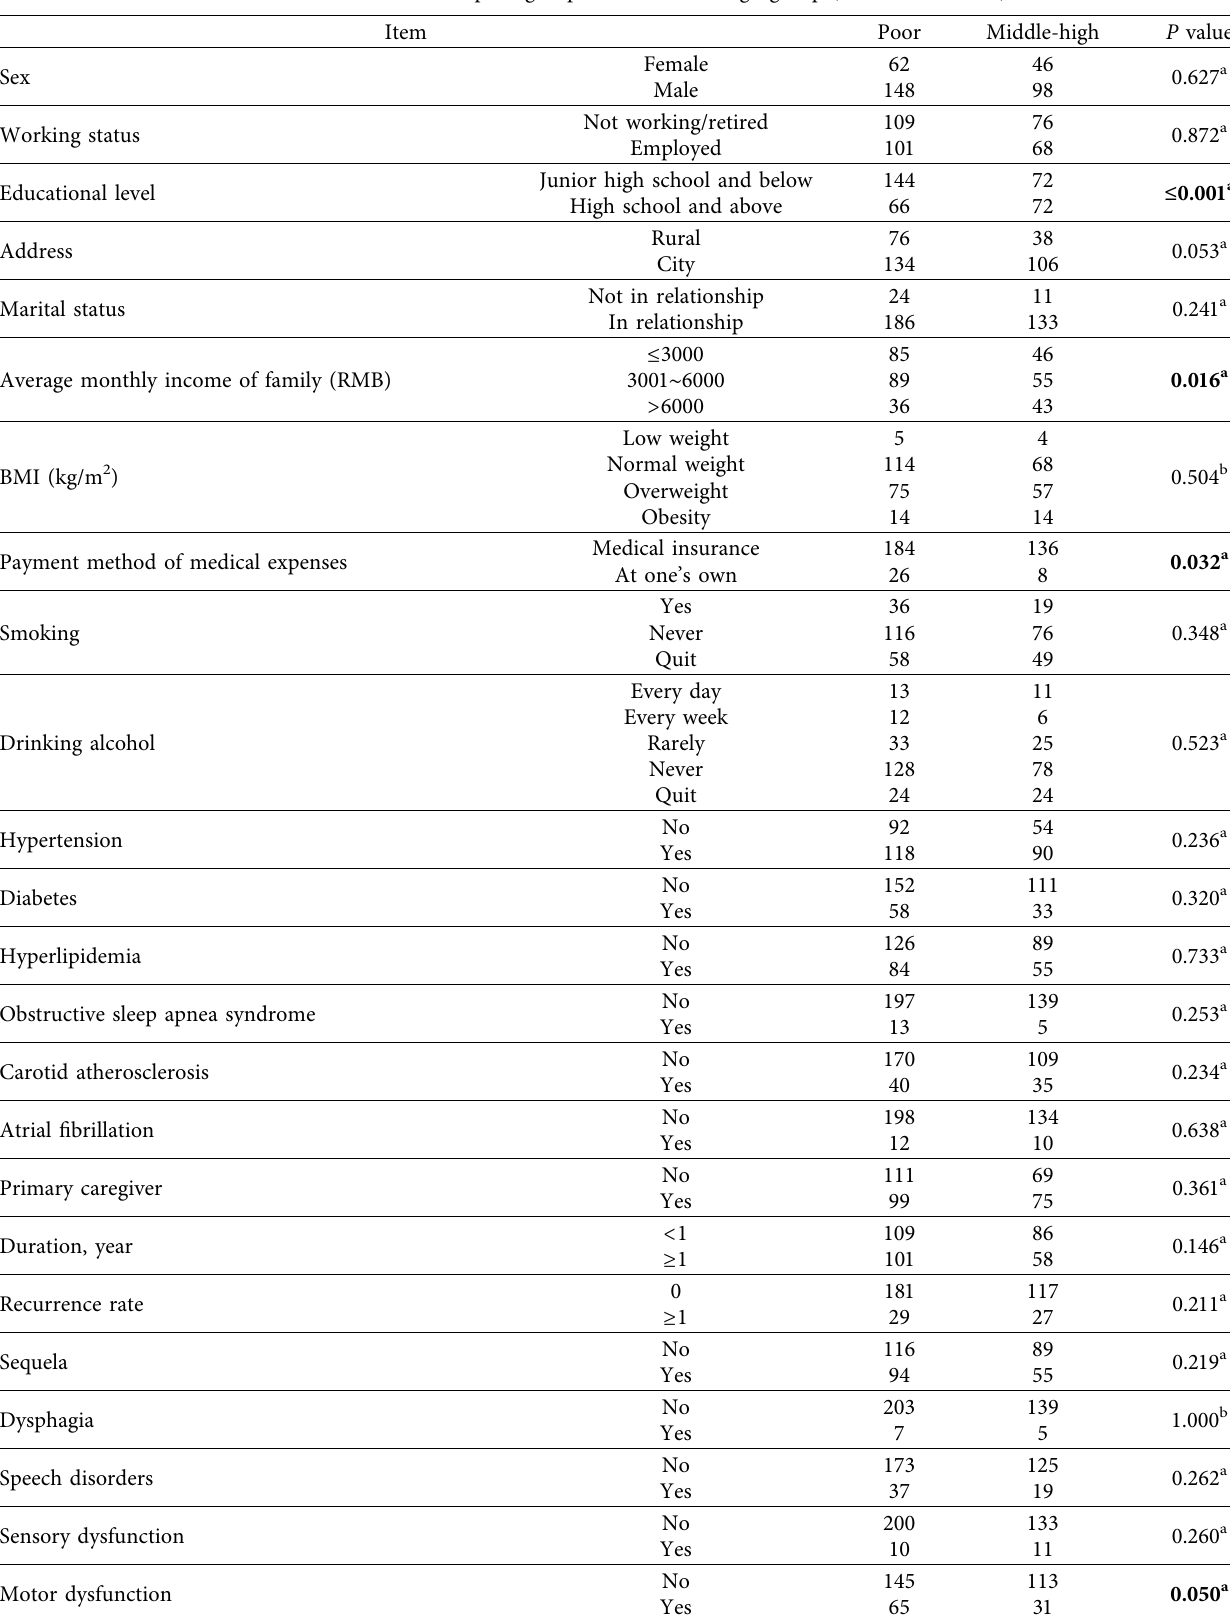
Table 5: Characteristics of poor group versus middle-high group (classifcation